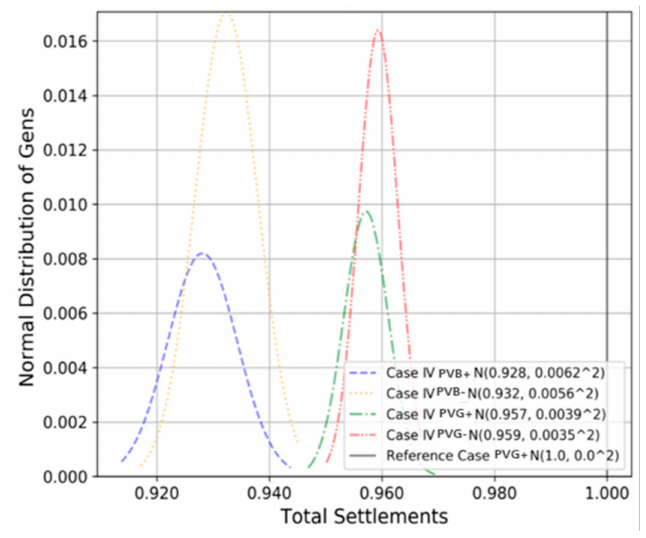
Figure 9. Distribution of PVs revenue in each group under Case